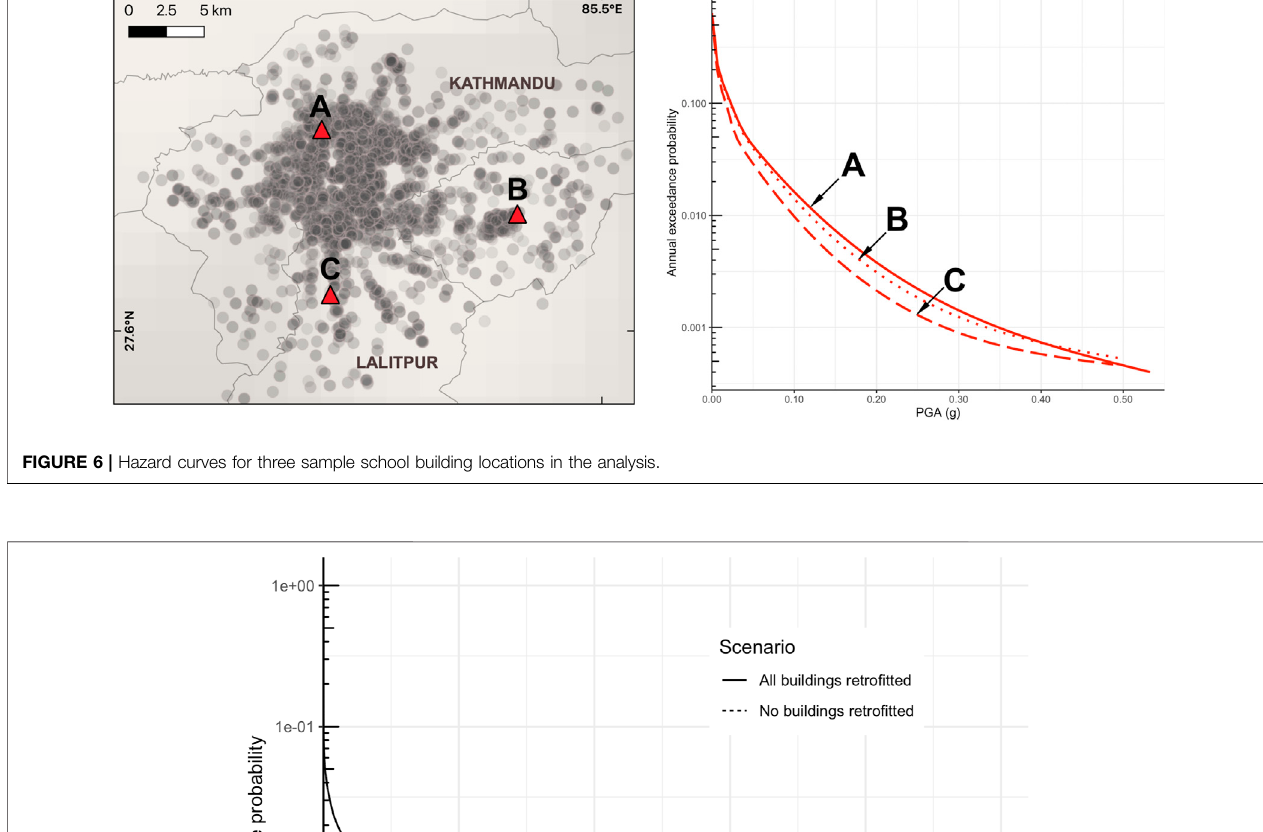
Frontiers in Earth Science |